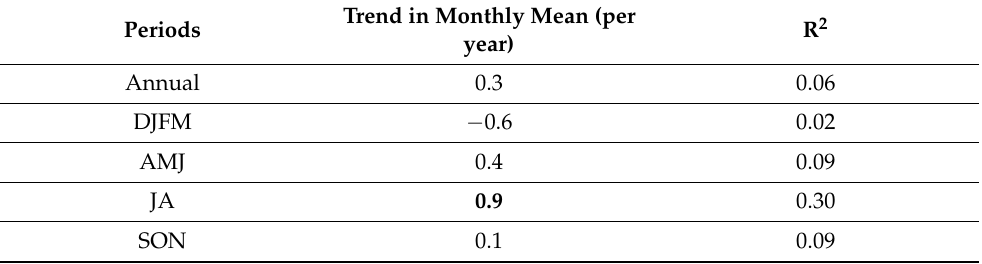
Table 4. Trend values for the all-island fire frequency monthly means calculated annually and for each season December − March, April − June, July − August, and September–November. Values in bold are significant at the 95% level. R 2 is the coefficient of determination and represents the proportion of variance explained by the trend. Trend in Monthly Mean (per Periods R 2